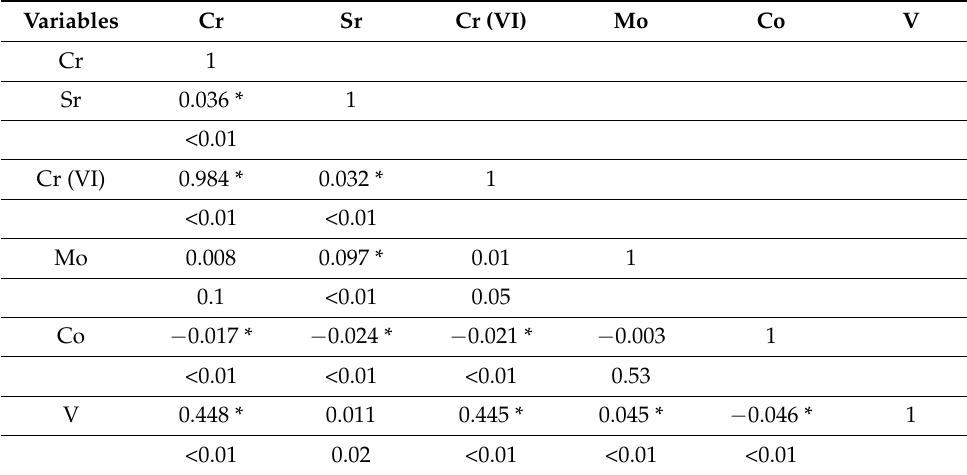
Table 2. Pairwise correlations of predicted geometric means of large public water systems (>10,000 people served) by contaminant with p value for the correlation on the second line. Variables